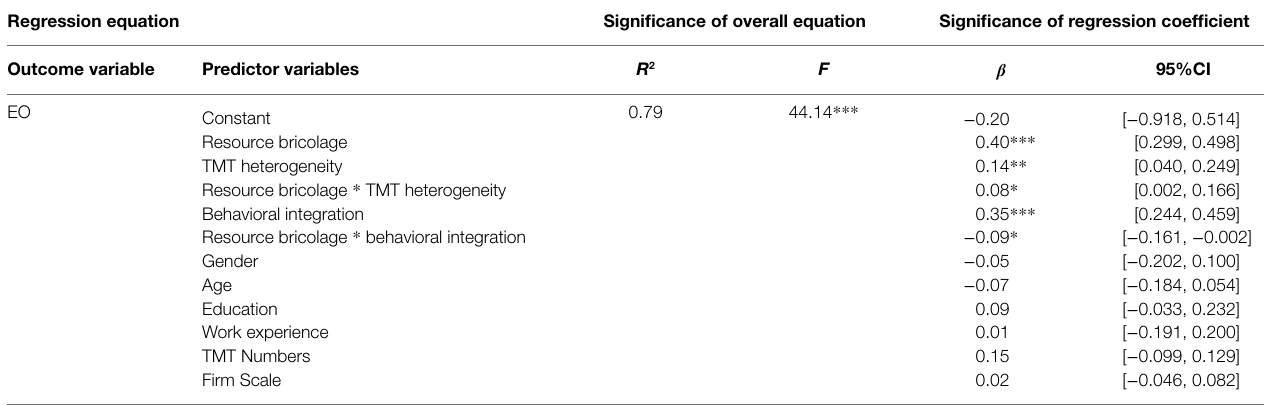
TABLE 5 | Double regulation